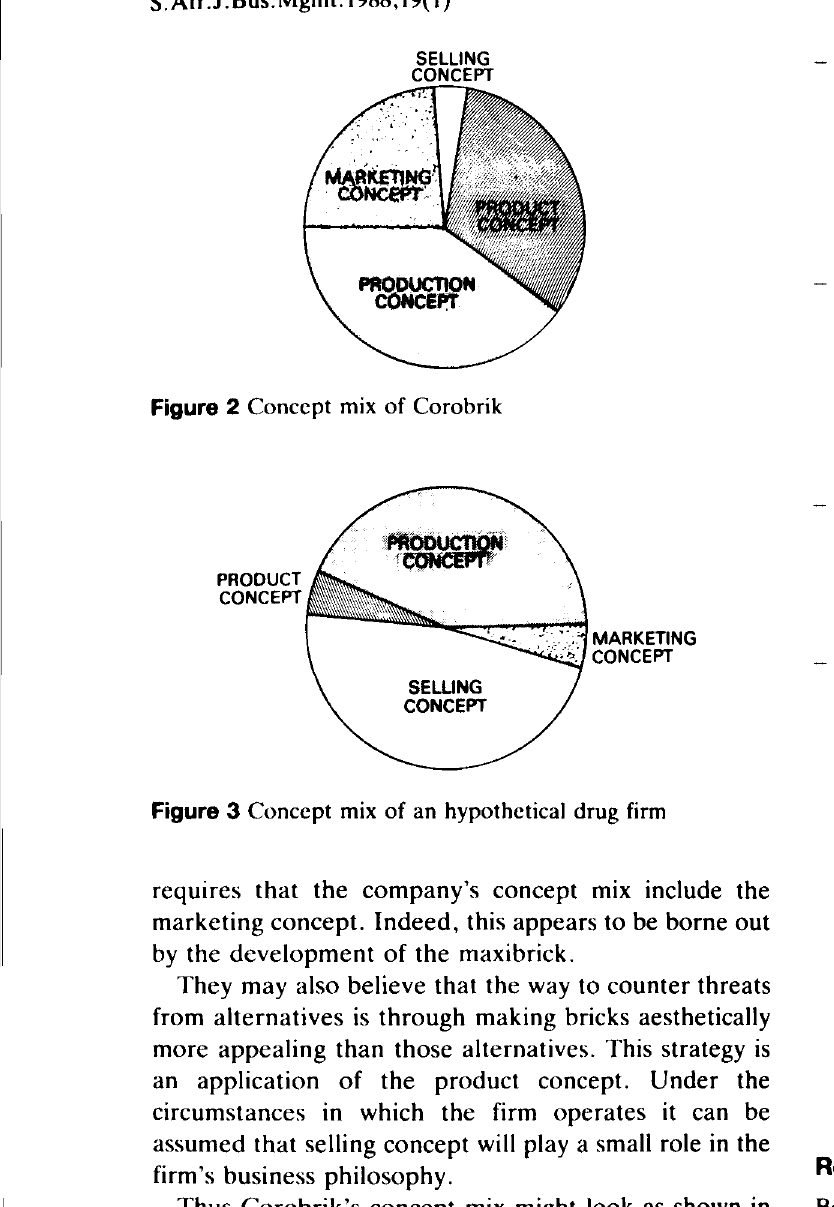
Figure 2 Concept mix of Corobrik